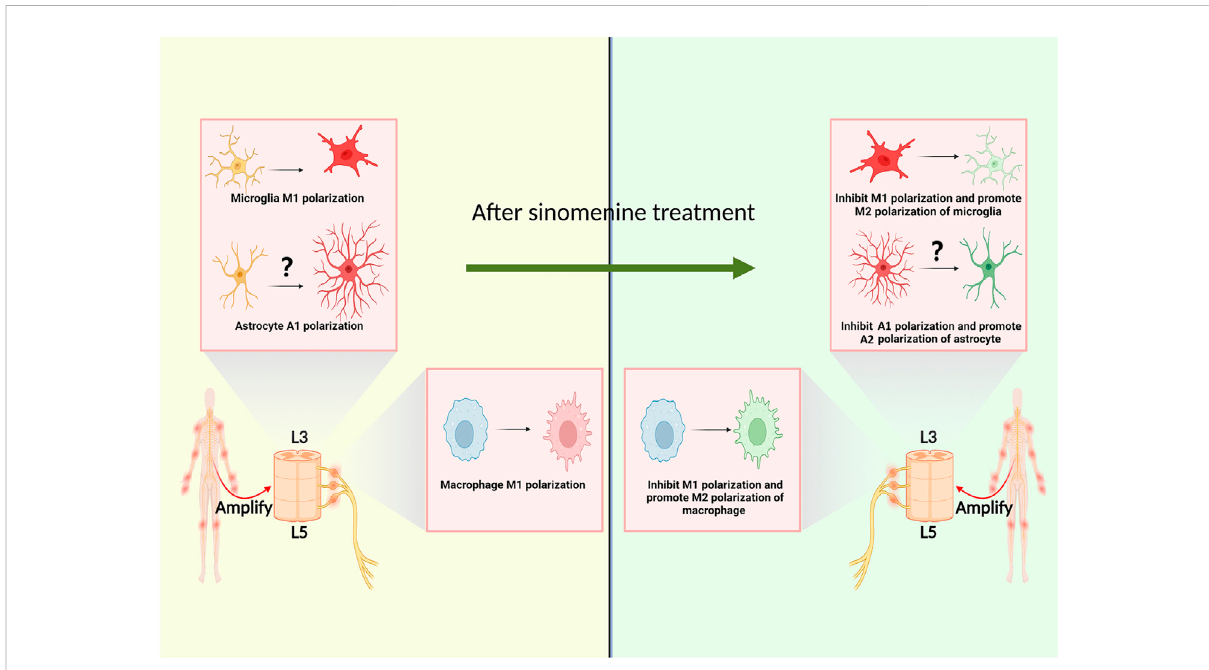
FIGURE 3 Sinomenine inhibits chronic pain by affecting the polarization of macrophages and glial cells.